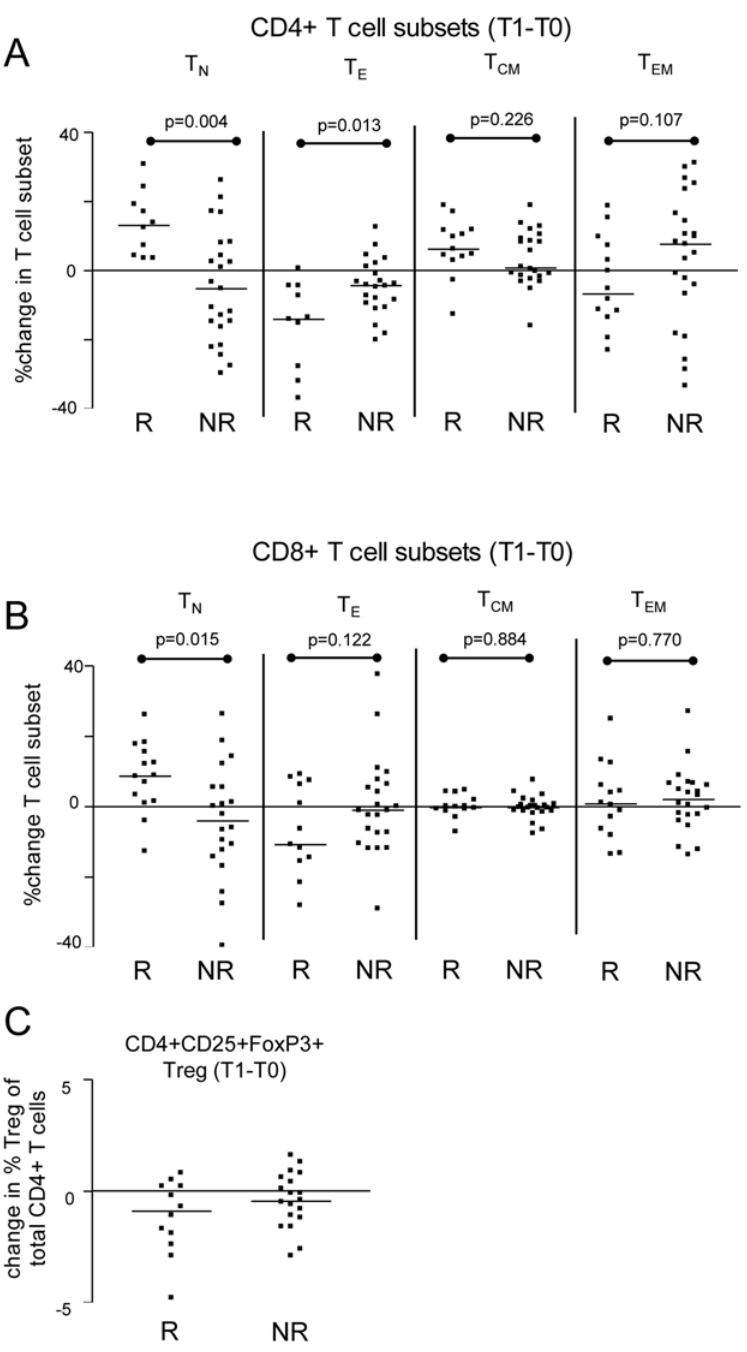
Figure 4. Changes in the frequency of naı¨ve, effector, memory and regulatory T cell subsets in the peripheral blood of transplant patients between the time of transplantation (T0) and the start of tacrolimus withdrawal (T1). A positive value indicates an increase and a negative value indicates a decrease of the value in time. The change in the percentage of naı¨ve (T N , CD45RA + CD62L + ), effector (T E , CD45RA + CD62L-), central memory (T CM , CD45RO + CD62L + ) and effector memory (T EM , CD45RO + CD62L-) T cell subsets within (A) the total CD4 + T cell population, and (B) the CD8 + T cell population. (C) The change in the percentage of peripheral blood CD4 + CD25 + FoxP3 + T cells within the total CD4 + T cell population.. R vs. NR=not significant.